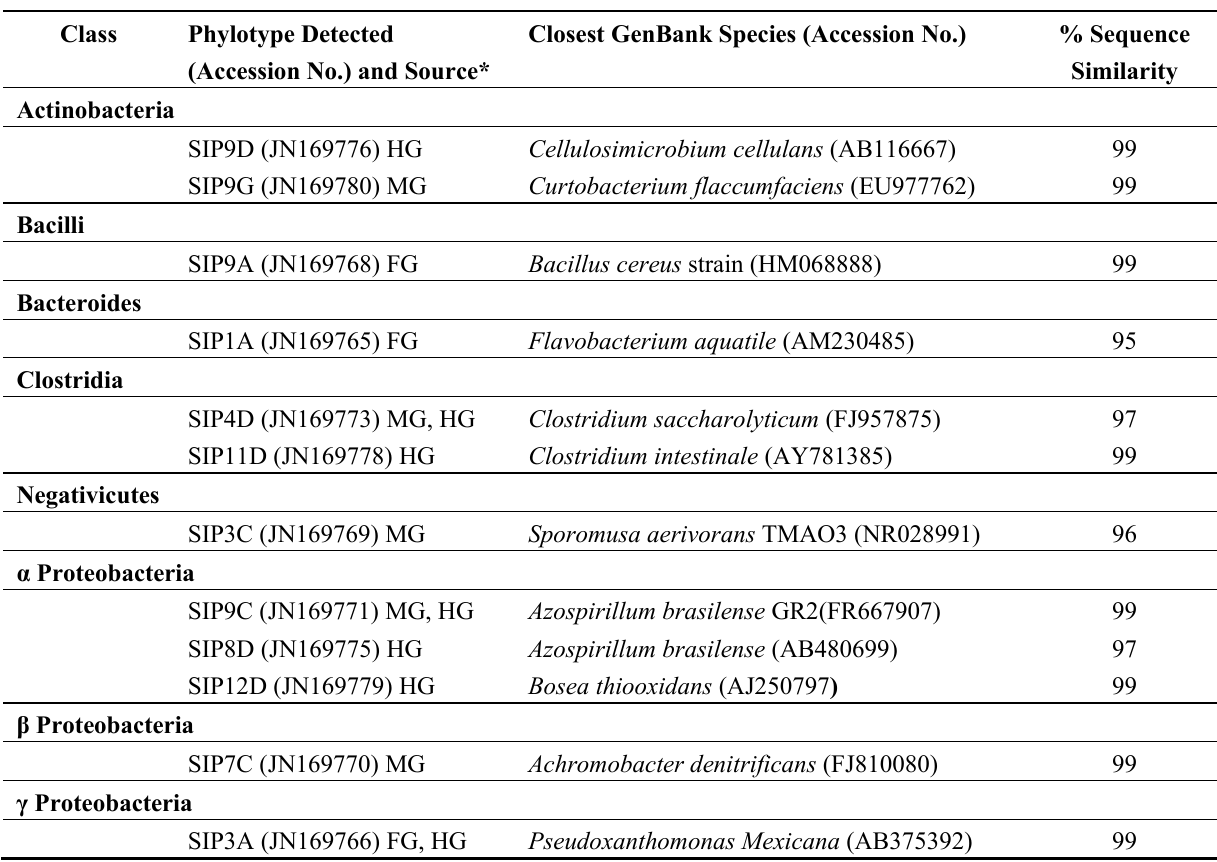
Table 2. Sequence similarity of OTUs detected in 16S rRNA gene clone libraries generated from DNA-stable isoptope probing (SIP) using enrichments inoculated with different GI tract regions from P.